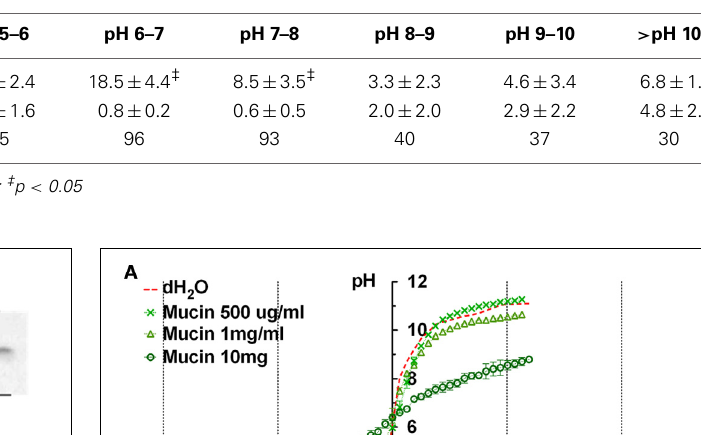
Table 2 | pH-dependent buffer capacity ( β ) of forskolin-stimulated Calu-3 secretions before and after neutralizing bicarbonate * .